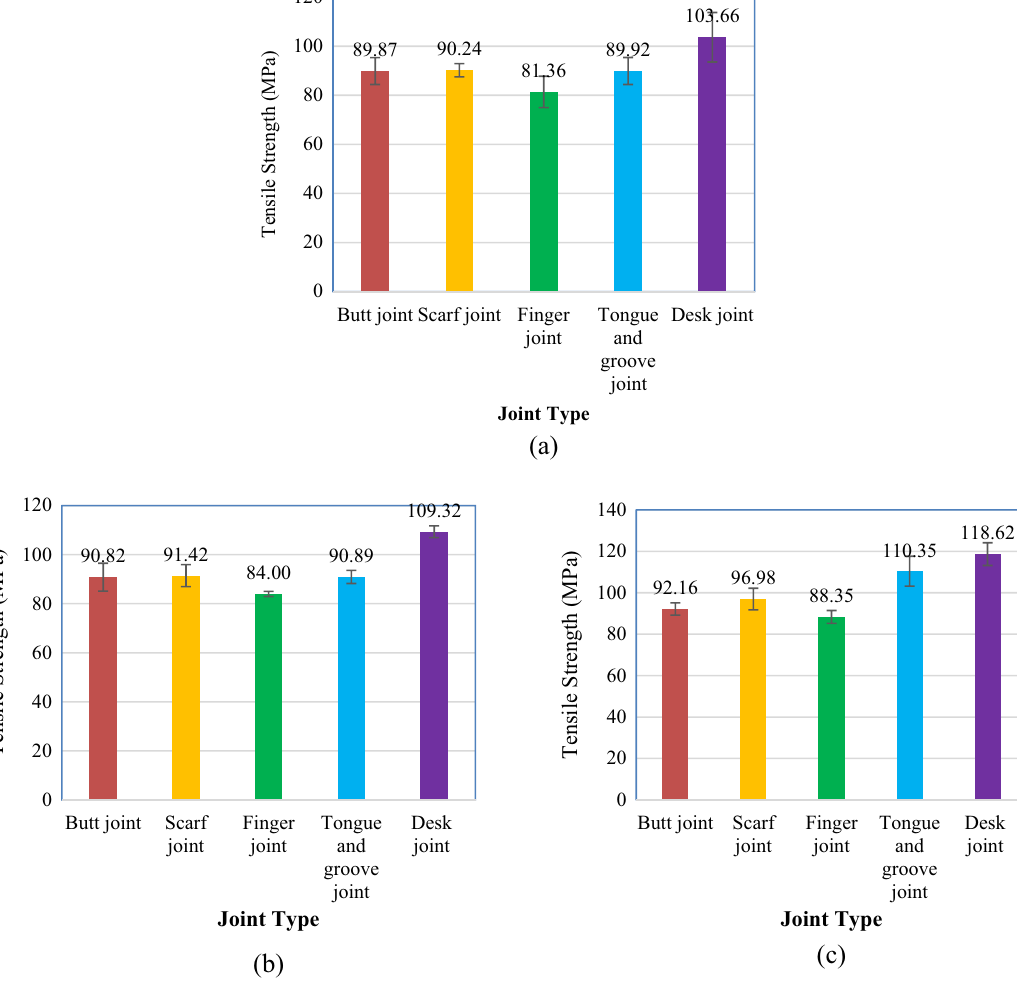
Figure 8: Comparison of tensile stress of di ff erent joint types for ( a ) three layers, ( b ) fi ve layers, and ( c ) seven